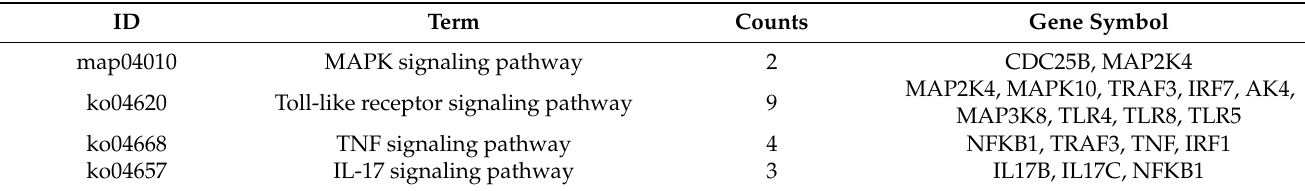
Figure 8. Regulatory network of differentially expressed miRNAs and mRNA of target genes. Red triangles represent miRNAs, and blue circles represent mRNAs. Table 6. KEGG pathways enriched for target genes.